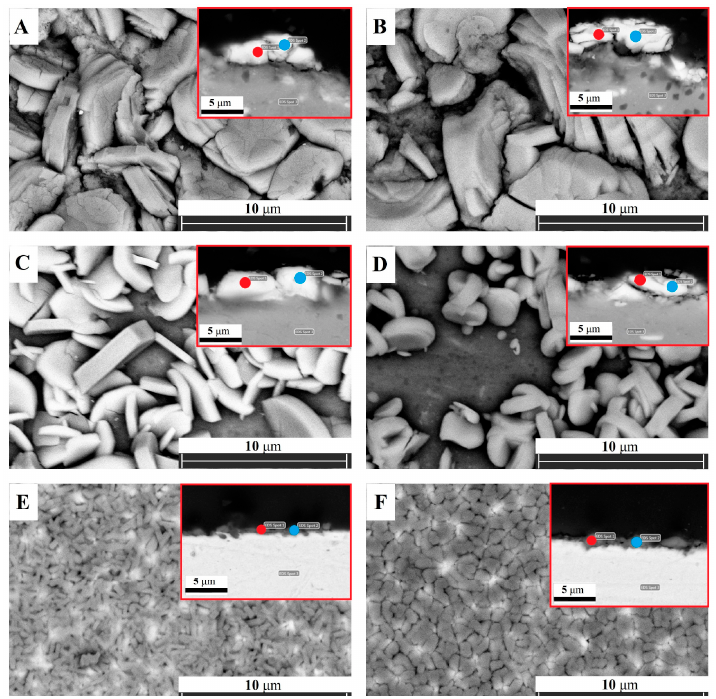
Figure 6. The higher magnification SEM images of the phosphate coatings: AL1-N ( A ), AL1-NG ( B ), AL2-N ( C ), AL2-NG ( D ), ST-N ( E ), ST-NG ( F ). The parts marked with a red square show the images of the cross-sectional